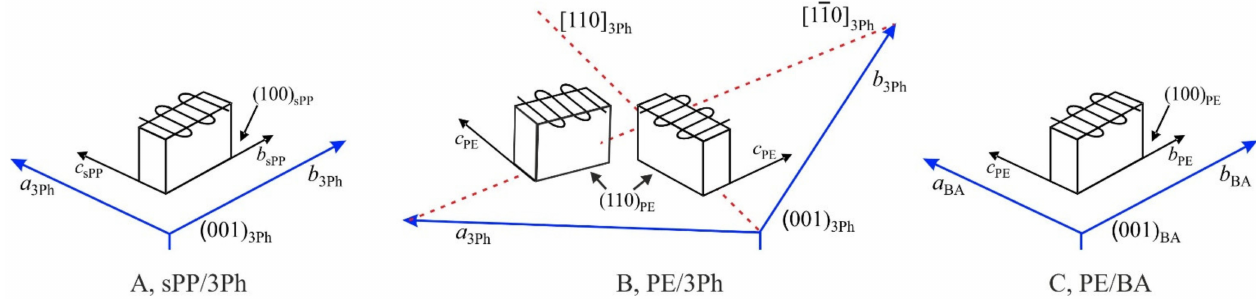
Figure 6. Schemes of the single orientation of crystalline lamellae of sPP ( A ) and double orientations of PE lamellae ( B ) onto the (001) face of 3Ph and of the single orientation PE lamellae onto the (001) face of BA ( C ), induced by epitaxial crystallization